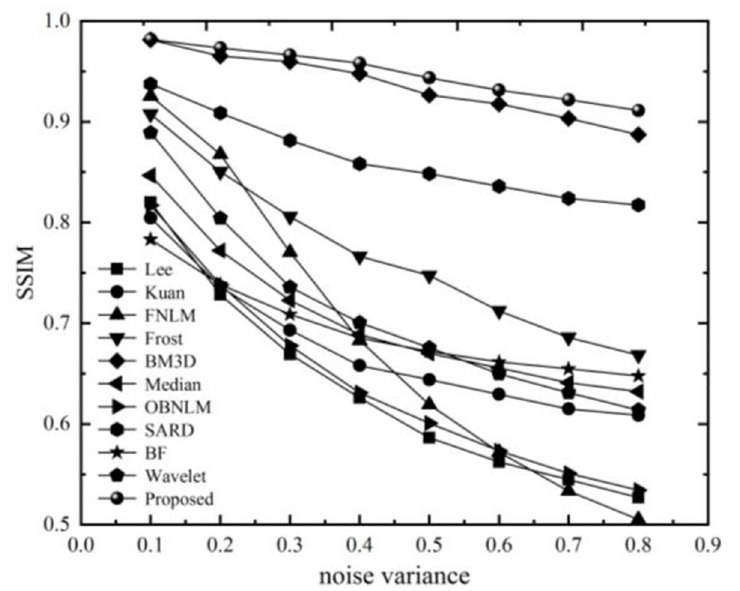
Fig 7. SSIM value of each algorithm under different noises.